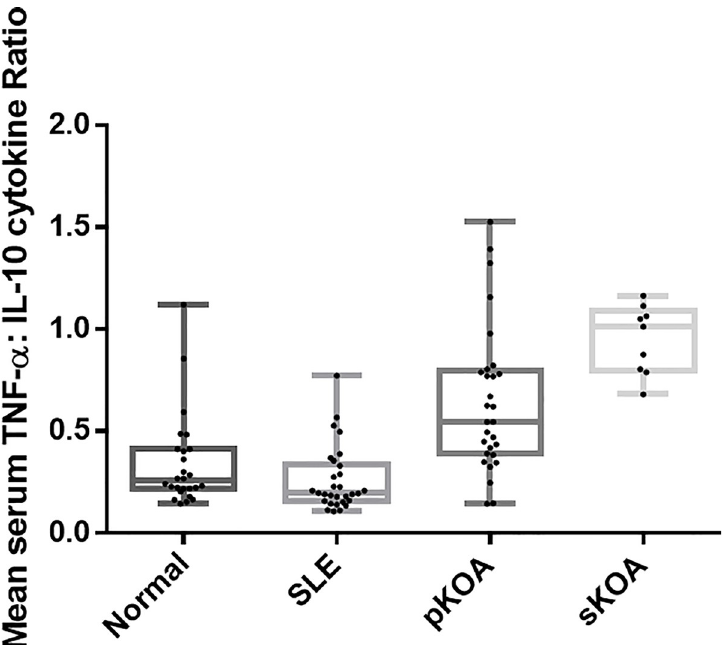
Fig 3. TNF- α : IL-10 (Th1: Th2) cytokine ratio of the four study groups (Whiskers extend from the smallest value to the largest value of each data set; Normal: Normal, healthy controls, SLE: Systemic Lupus Erythematosus disease controls, pKOA: Primary knee osteoarthritis, sKOA: Secondary knee